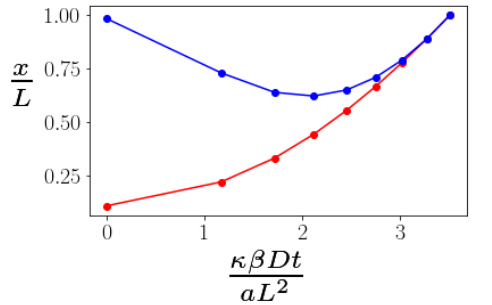
Figure 4. The time evolution of the distance between two defects (red) and the end-to-end distance of the bundle (blue) under a constant applied tensile force F = 0.9 κ non-dimensionalized time. The cross linker binding energy is µ = 4 κ